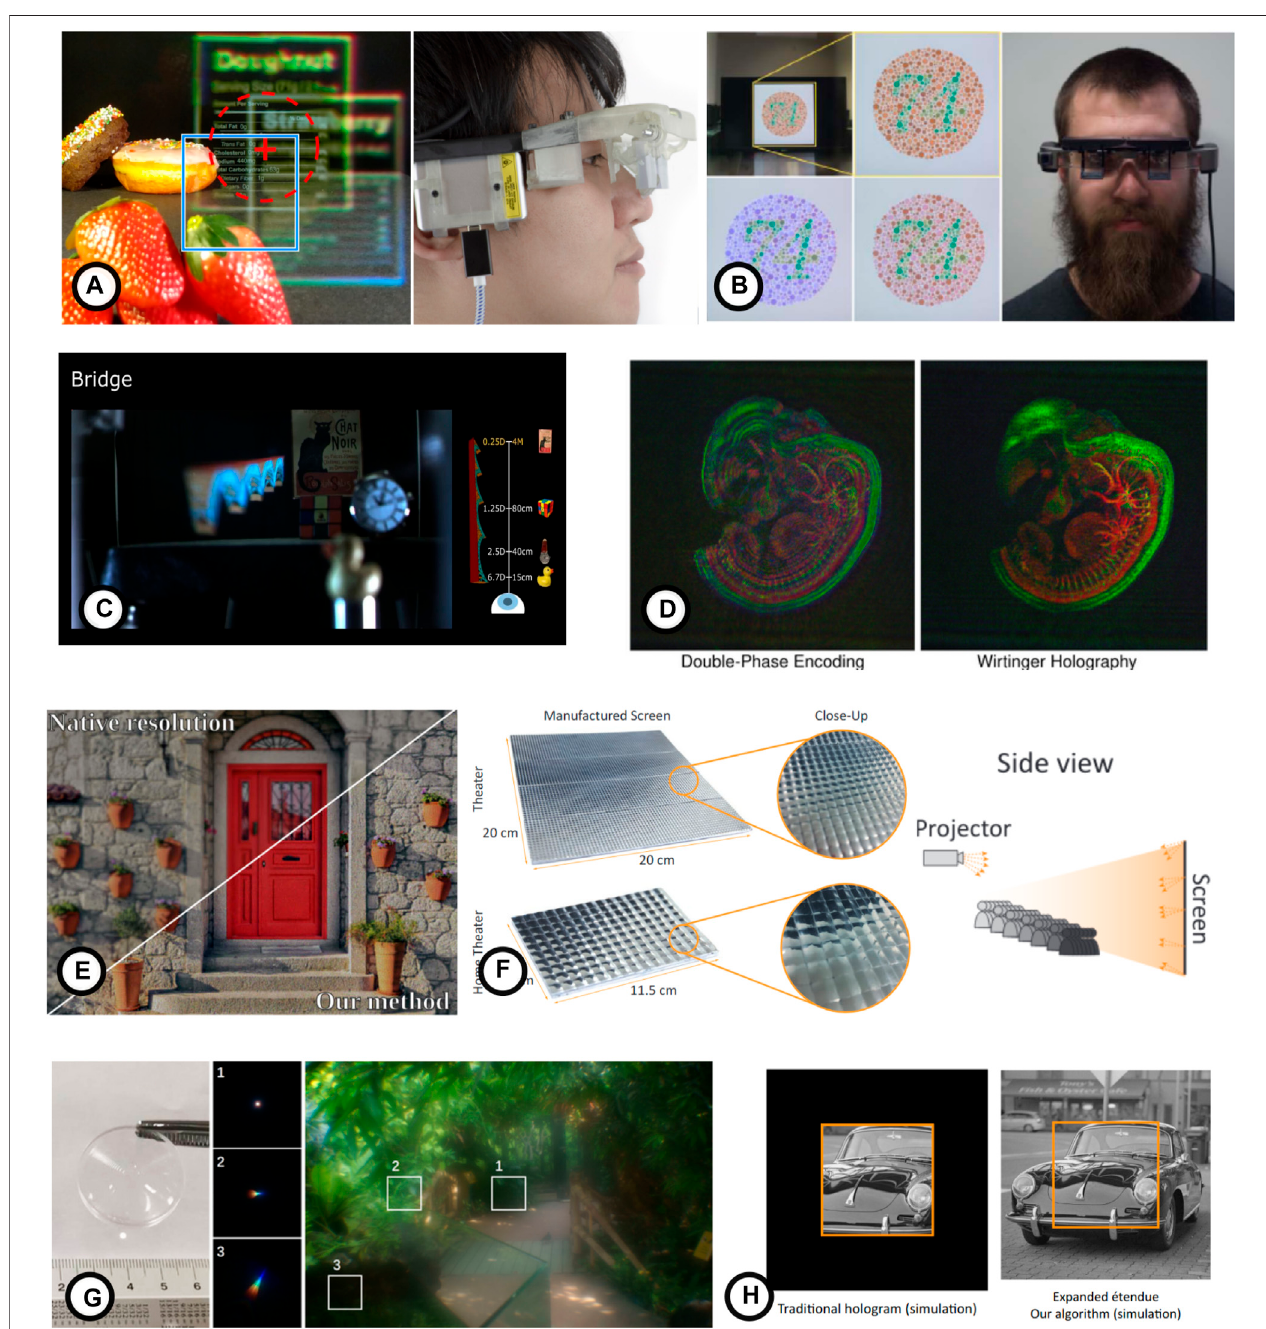
FIGURE 4 | Some examples of the next generation display technologies discussed in Section 5.1: (A) An image showing a foveated near-eye displays (right) , whichimprovestheresolutioninthecentral fi eldofview(contentintheredgazecircleintheleftimage)andhencetheperceivedresolutionoftheentirevirtualimage.(Kim etal.,2019), (B) Anexampleofacolorcorrectingnear-eyedisplays (right) ,whichcanamplifycolorssuchthatvisuallyimpairedindividualscanpasscolorblindnesstests (left) (Langlotz et al., 2018), (C) the view through a varifocal occlusion capable near-eye display, where augmented objects can be perceived as if they are part of real scene (Rathinavel et al., 2019), (D) The Wirtinger holography technique (Chakravarthula et al., 2019), which can improve the visual quality in holographic displays (right) vs. double-phase encoding (left) , (E) Resultingimage ofanew scanning method (Ak ş it,2020) (lower right) thatcanenhance resolution and refresh rateinnext- generation displays; (F) Images showing the detailed structure of directional screens, which (Piovar č i et al., 2017) can provide brighter images for multiple users, (G) images of new optics (left) based on learned Fresnel lens designs (Peng et al., 2019), showing point-spread functions (center) and a sample light fi eld (right) , and (H) Images showing the relative fi eld of view of a holographic display (right) vs. a traditional display (left) , which can be wider with new expansion techniques (Kuo et al., 2020).